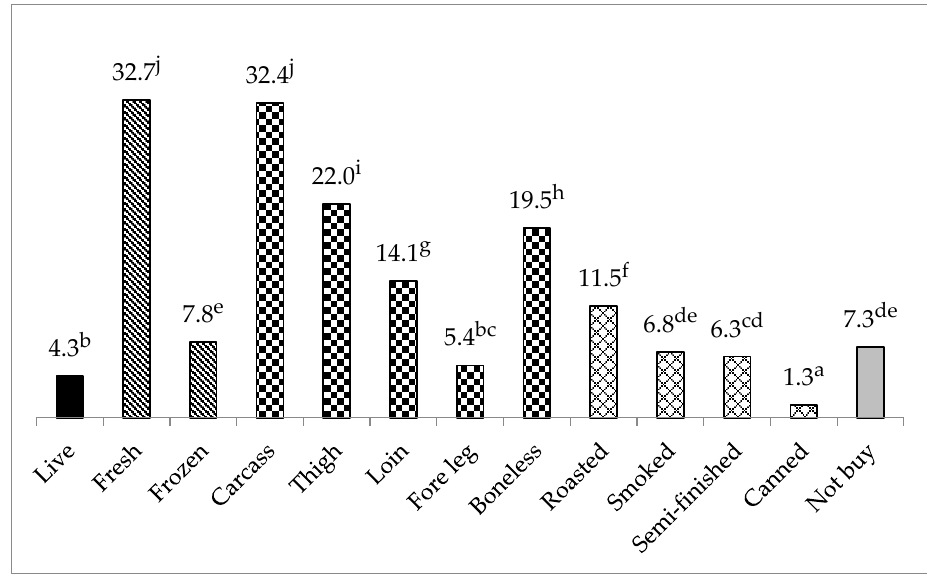
Figure 2. Effect of rabbit meat forms on consumers’ buying decision (% ; multiple response option). Figure 2. E ff ect of rabbit meat forms on consumers’ buying decision (%; multiple response option). The columns of live, fresh and frozen, the whole carcass and its parts, the prepared meat products and who do not buy rabbit meat are marked with di ff erent patterns. a–j Means with di ff erent superscripts di ff er at p <